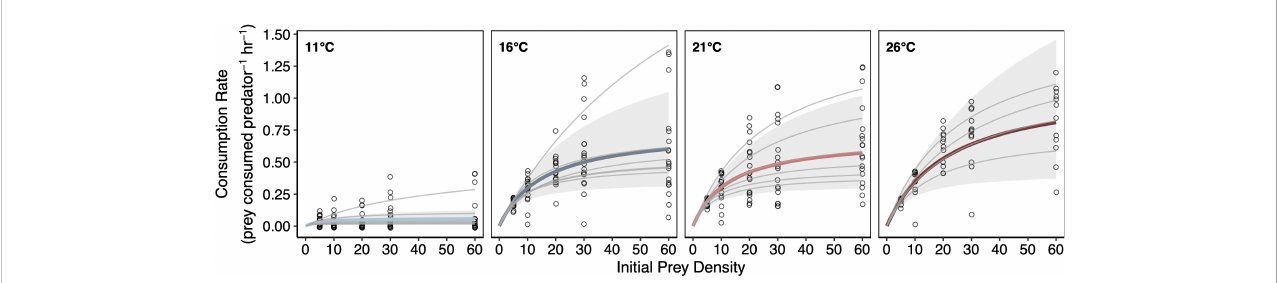
FIGURE 4 Temperature Effects on Lobster Maximum Consumption Rates. Median estimates of maximum consumption rates ( C max ) for each individual lobster (gray points in background) and lobsters in each temperature treatment (colored points). Colored points represent treatment medians ± 95% CI ’ s. Black line and surrounding shading are the median ± 95% CI of the bootstrapped regression relationship between temperature and maximum consumption rate fi t to the treatment-level posterior estimates. Individual median estimates (gray points) are jittered for clarity.